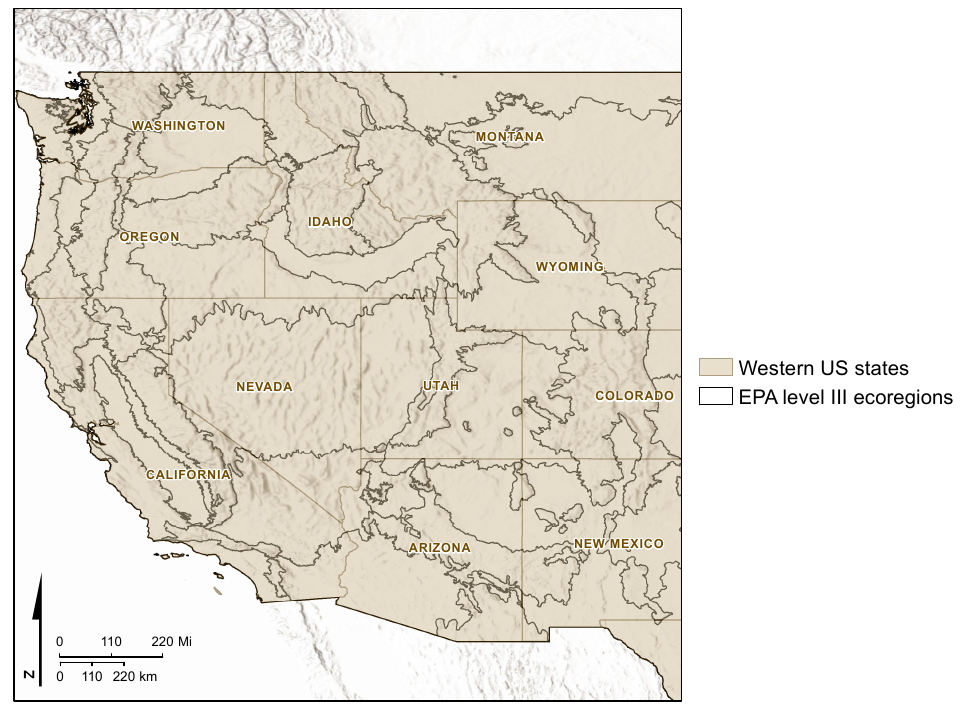
Figure 1. The dataset described in this paper predicts conditional large fire probability across forests and woodlands in the 11 contiguous western US states. Environmental Protection Agency (EPA) level III ecoregions were used to stratify sampling and create a spatially balanced 1 : 1 sample of small and large fires across diverse ecoregions, which was then used to train a single random forest model across the western US to predict large fire